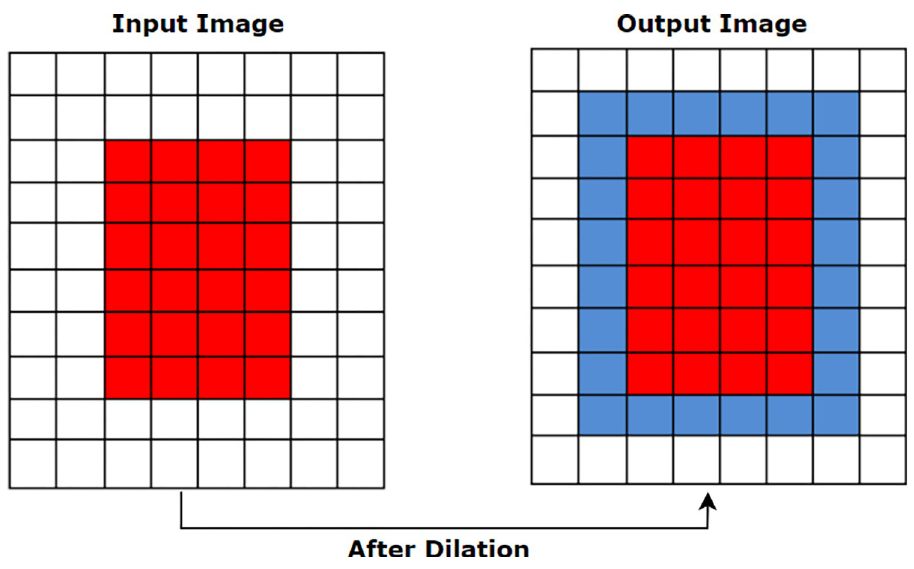
Fig 11. Changes of pixels after applying morphological